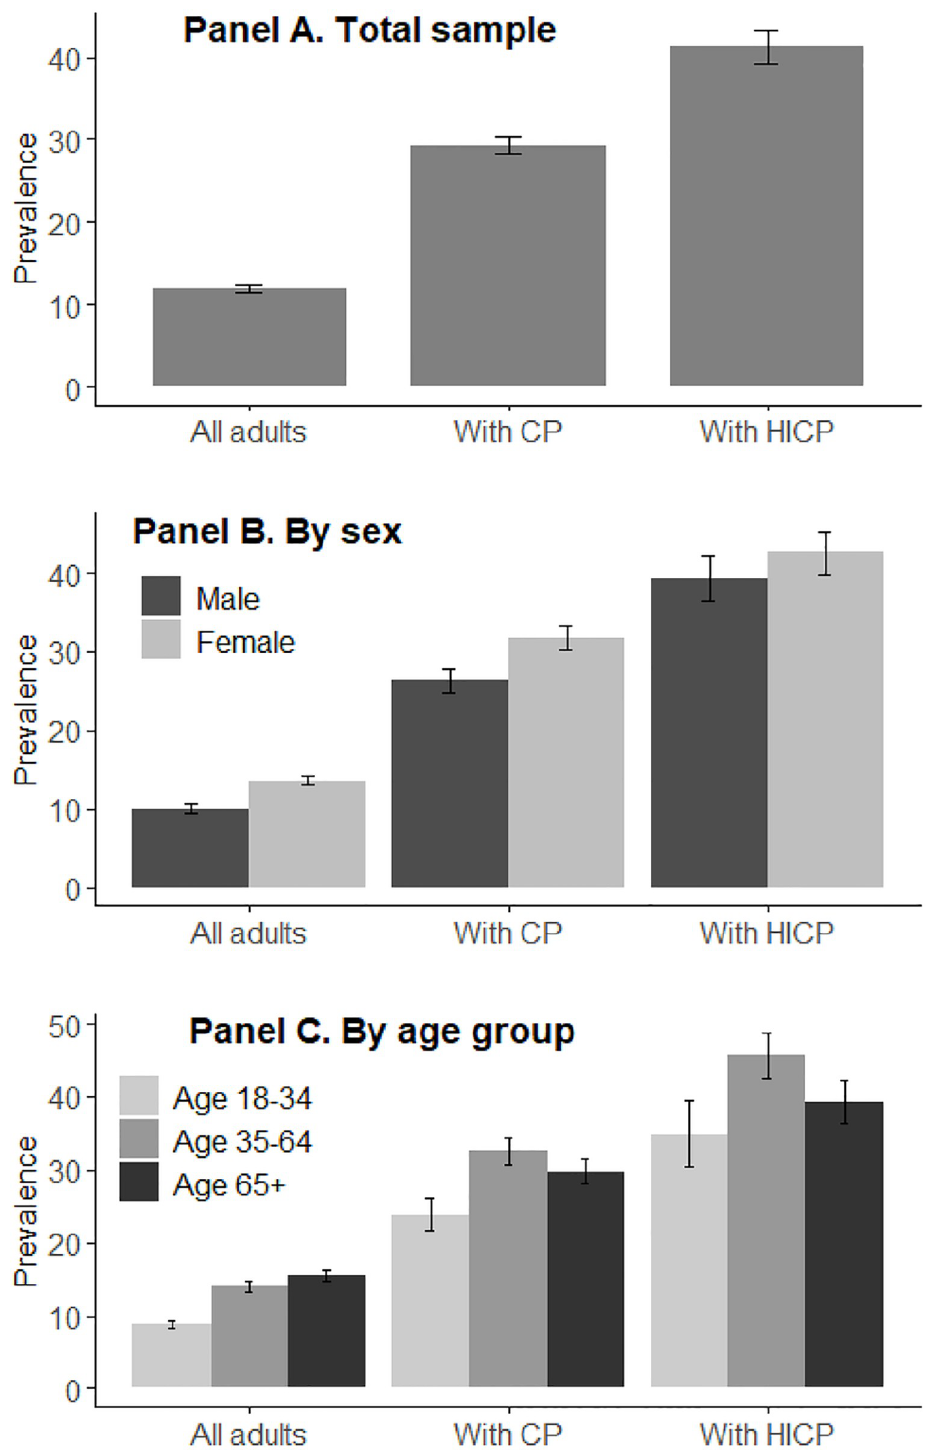
Fig 1. Prevalence of prior-year prescription opioid use among US adults, by pain status, sex, and age group. CP = chronic pain; HICP = high-impact chronic pain. Each plot shows prevalence estimates and their 95% confidence intervals. Estimation adjusts for NHIS complex sampling design. N =